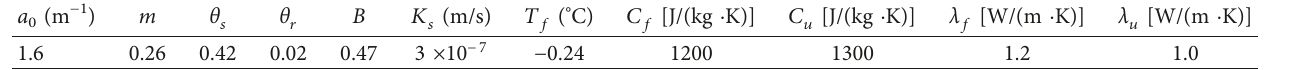
Table 2: Model parameters of thawing experiments.